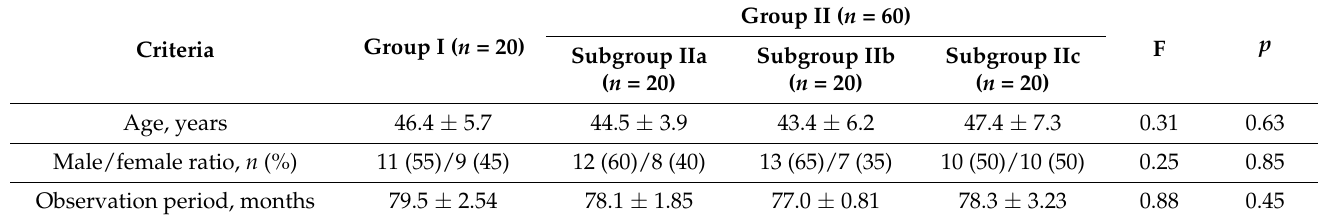
Table 1. Patient demographic information.